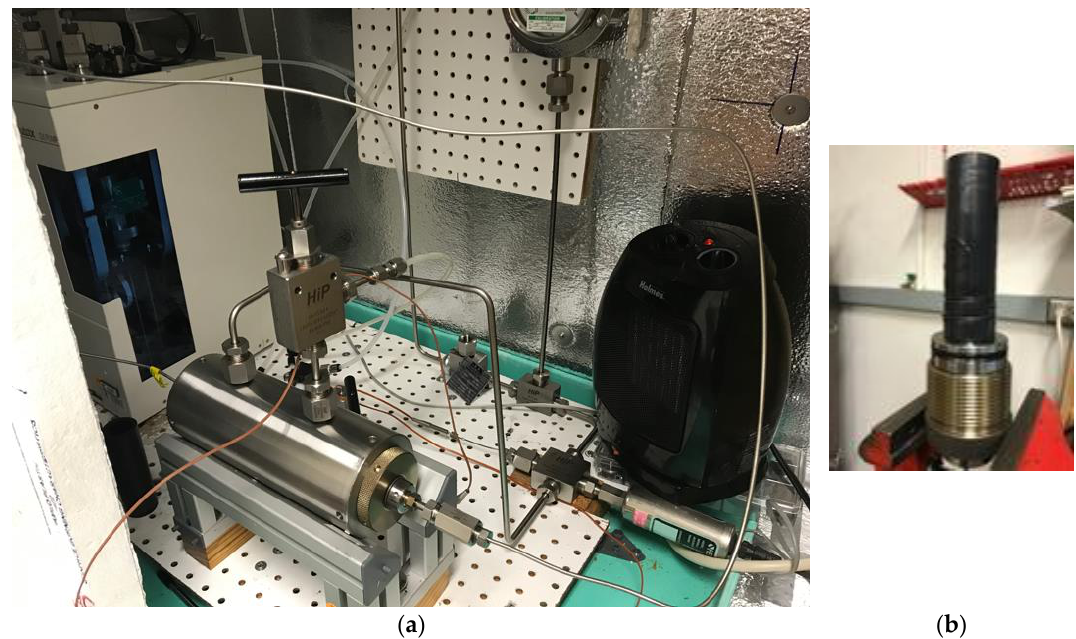
Figure 1. Photos of ( a ) test chamber, and ( b ) jacketed sample placed on the core-holder.